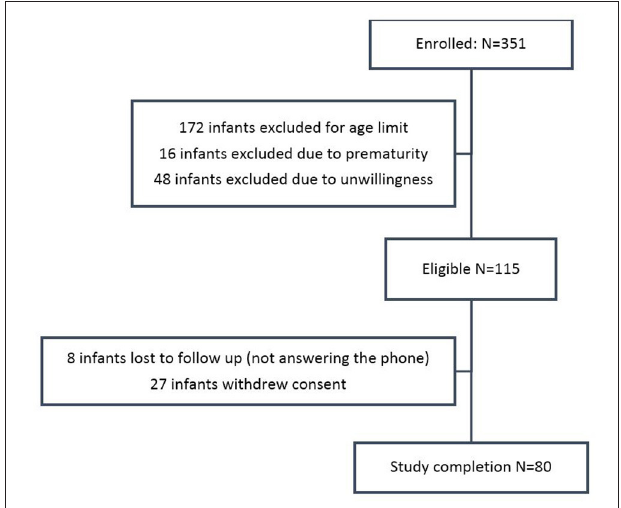
FIGURE 1 | The subject flowchart of the study.